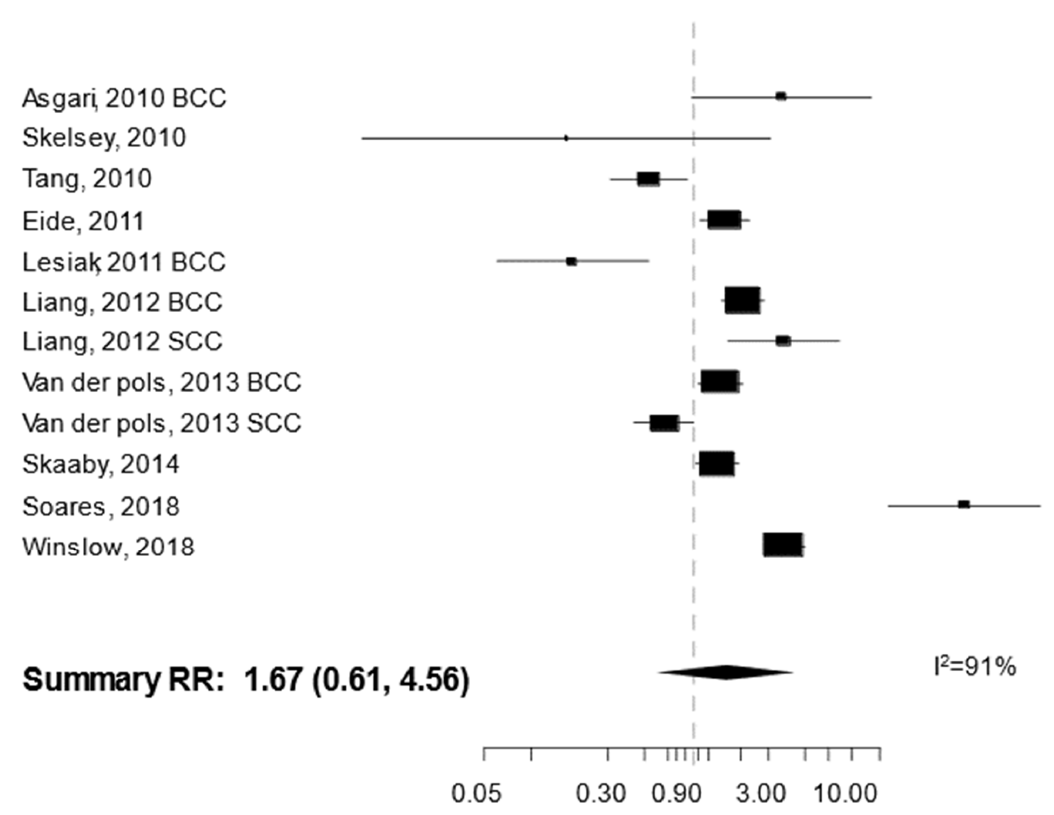
Figure 2. Forest plot for the association between the serum/plasma concentration of 25(OH)D (comparison: highest vs. lowest category) and the risk of non-melanoma skin cancer. BCC: basal cell cancer. SCC: squamous cell cancer. RR: relative risk.